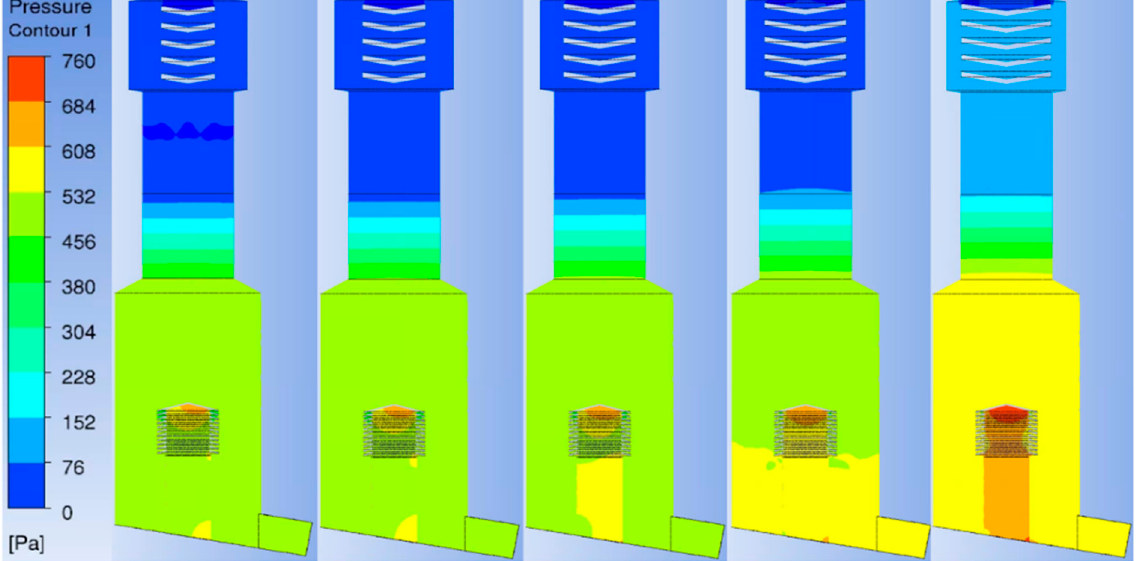
Figure 10. Pressure contour according to the vane length in the inner vane type.